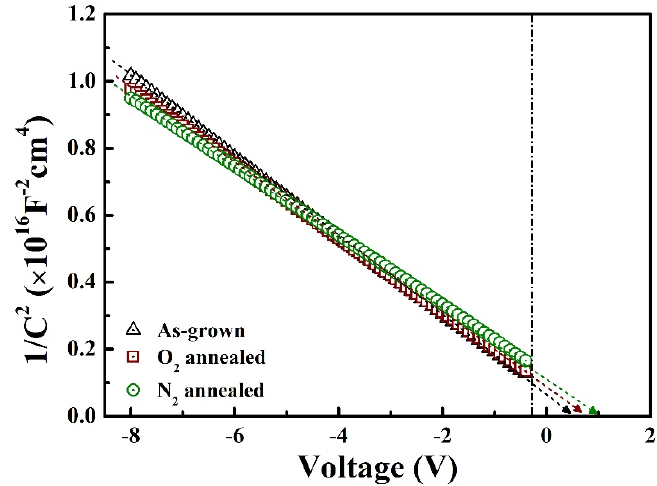
Figure 5. 1/C 2 –reverse voltage plots for different diodes measured at room temperature.